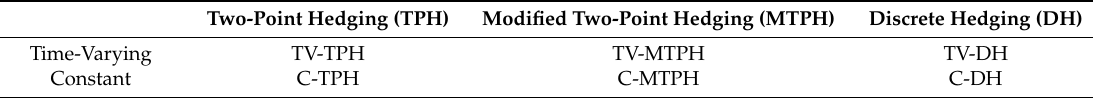
Table 2. The list of hedging models (with acronyms) used for comparison.